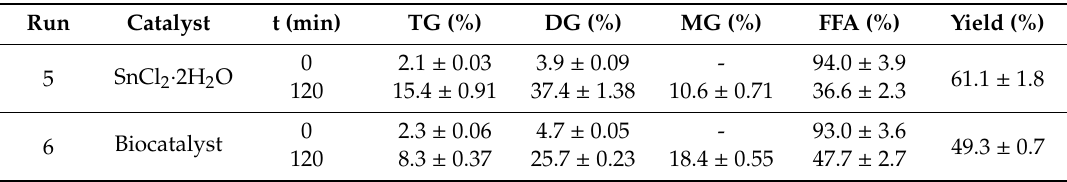
Table 3. Free fatty acid (FFA) conversion yield and triglyceride (TG), diglyceride (DG), monoglyceride (MG) and free fatty acid (FFA) content obtained by high performance size exclusion chromatography (HPSEC) at the beginning and at the end of the esterifications over SnCl 2 · 2H 2 O and the biocatalyst (mean ± SD, n = 2).